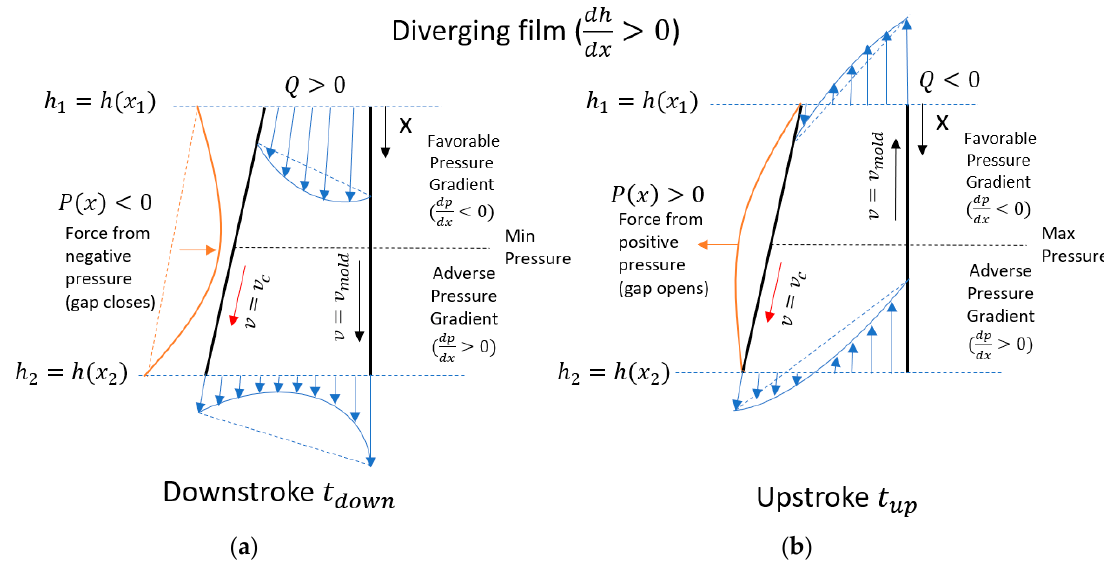
Figure 3. Velocity and pressure profiles in diverging slag film during mold oscillation cycle: ( a ) At downstroke, ( b ) at upstroke.